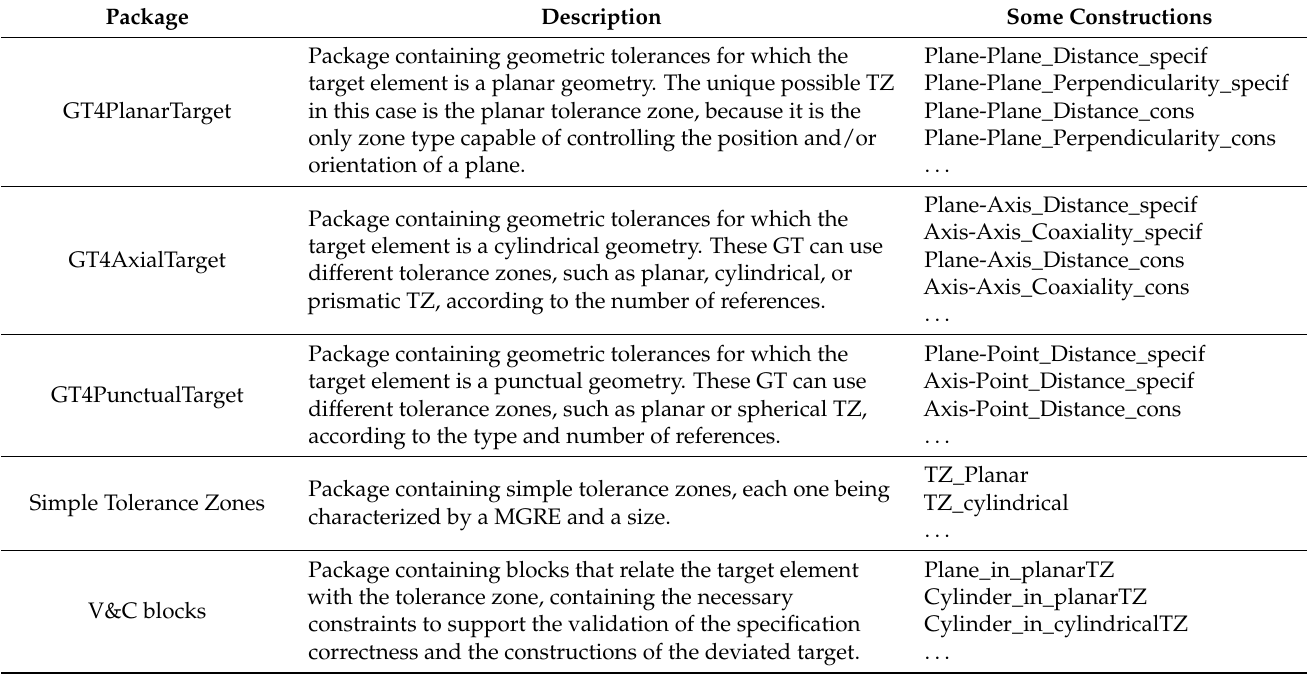
Figure 11. Diagrams related to TTRS ‐ based representation for planar feature: ( a ) IBD of MGRE_planar block; ( b ) IBD of MGRE_planar_repr block; ( c ) IBD of PlanarF_repr block; ( d ) PAR of PlanarF_repr block. Table 3. TSLP sub-packages and